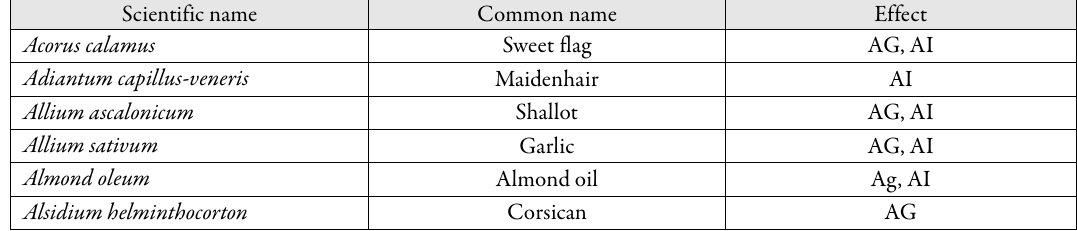
Table 12. Anti-inflammatory (AI) and analgesic (AG) substances introduced by Avicenna in his book (Mahdizadeh et al .,